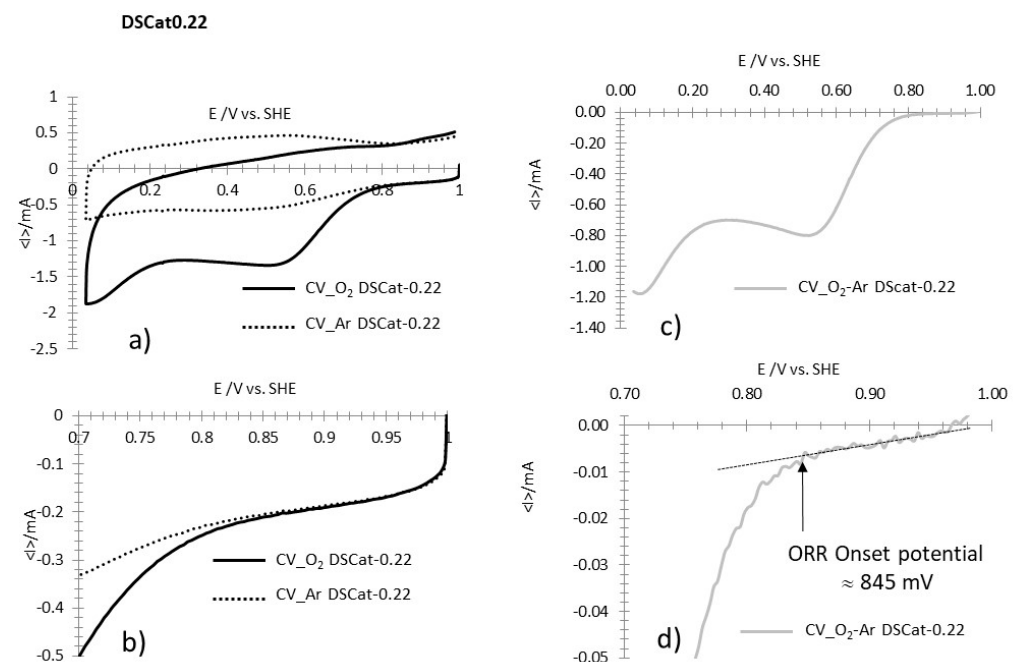
Figure A2. Example of determination of ORR onset potential for DSCat-0.22. ( a ) CVs recorded at 5 mV · s − 1 in O 2 saturated HClO 4 1M (CV_O 2 DSCat-0.22) and in Argon saturated HClO 4 1M (CV_Ar DSCat-0.22). ( b ) Enlargement of a) in the potential region of the ORR onset potential. ( c ) CV resulting from the di ff erence between CV_O 2 DSCat-0.22 and CV_Ar DSCat-0.22. ( d ) Enlargement of (c) in the potential region of the ORR onset potential, showing its determination (vertical arrow).